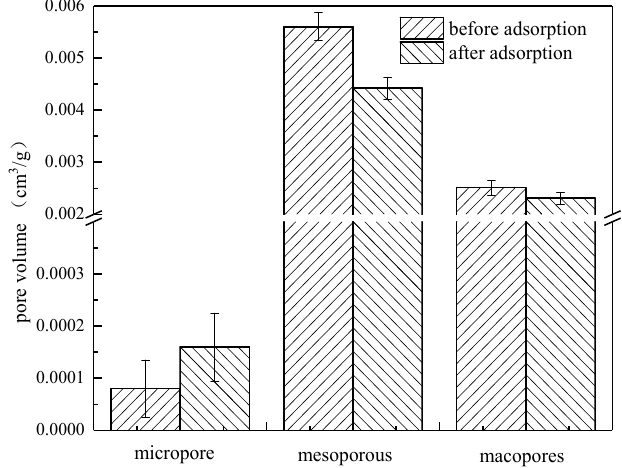
Figure 8. The pore volume of each type before and after the absorption of ROC by coking coal.